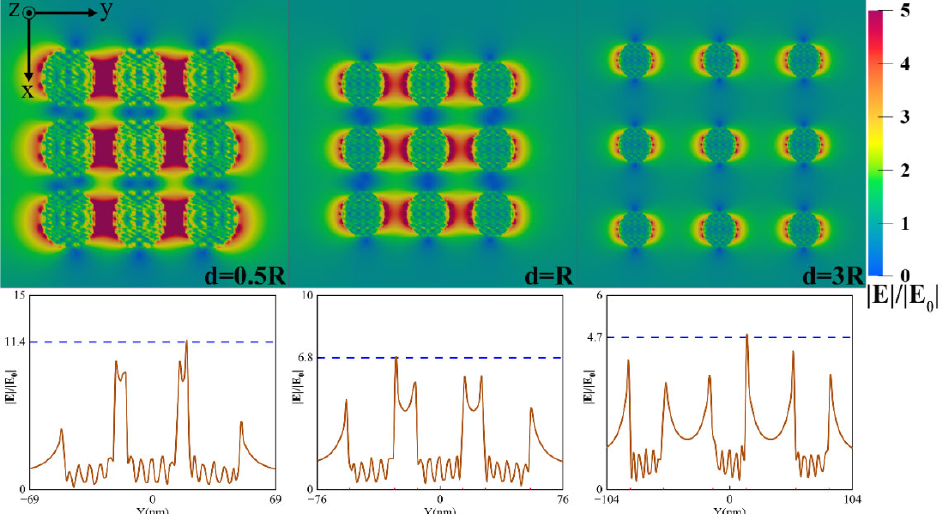
Figure 4. Near-field enhancement of the 3 × 3 square array of Ag nanoparticles with the radius of 14 nm and the incident light wavelength of 532nm: near-field distribution with different particle spacing (the top) and field enhancement factor curve along the y-axis of the array center (the